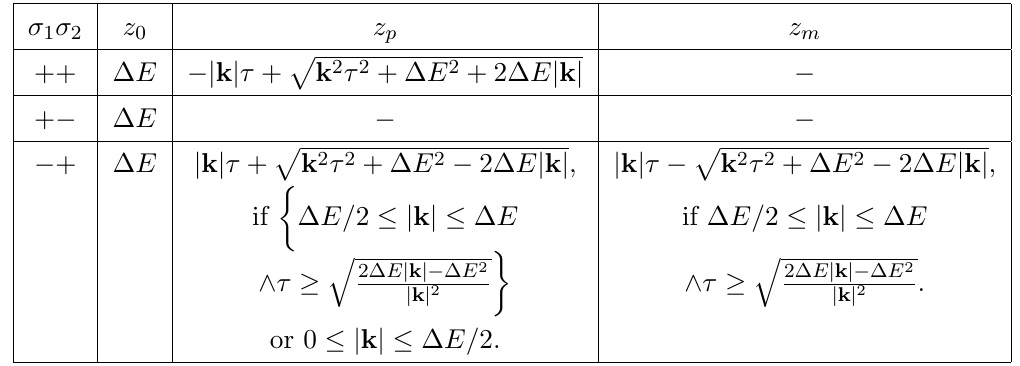
Table 1 . Summary of the real and positive poles of eq. (4.15), as well as their existence criteria. residue would diverge in the limit (cid:28) ! 1, re(cid:13)ecting the collinear divergence.